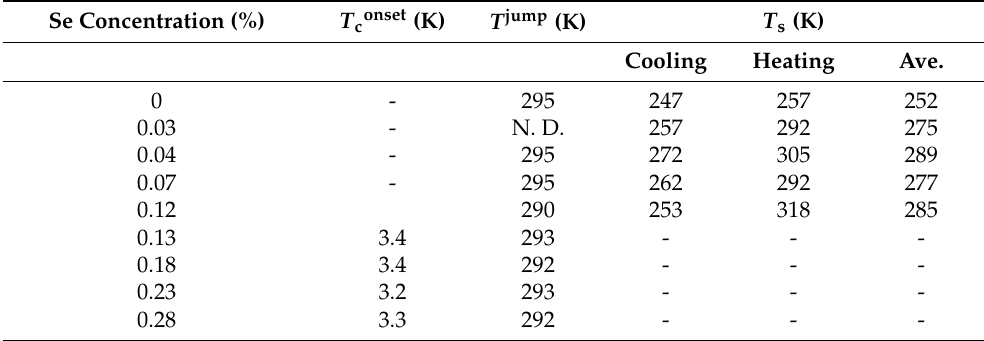
Figure 8. Phase diagram of the kink and superconductivity of the MoTe 2- x Se x single crystal. T s denotes the temperature that corresponds to the kink in the resistivity curve. The bars represent the temperature corresponding to the kink, which is estimated in the heating and cooling processes. T jump denotes the temperature attributed to the jump in specific heat. Red cross marks ( × ) indicate no superconductivity until 2 K. Table 3. T conset , T cjump , and T s values used in Figure 8. Hyphen (-) indicates that no transition was observed. N.D. implies that no measurement was